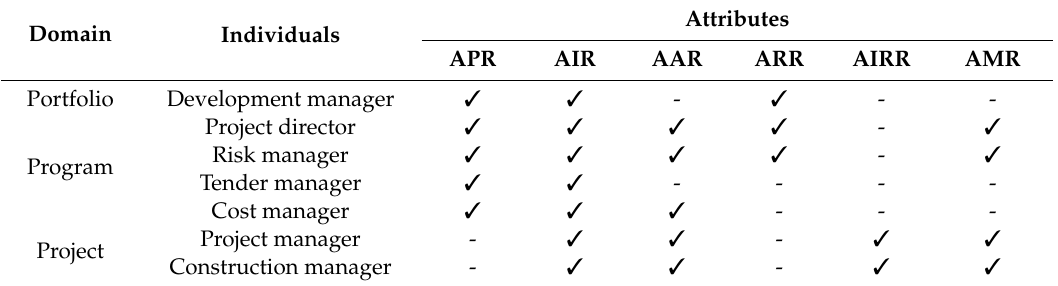
Table 6. Individuals expected to be involved in measuring the risk maturity in construction organizations.